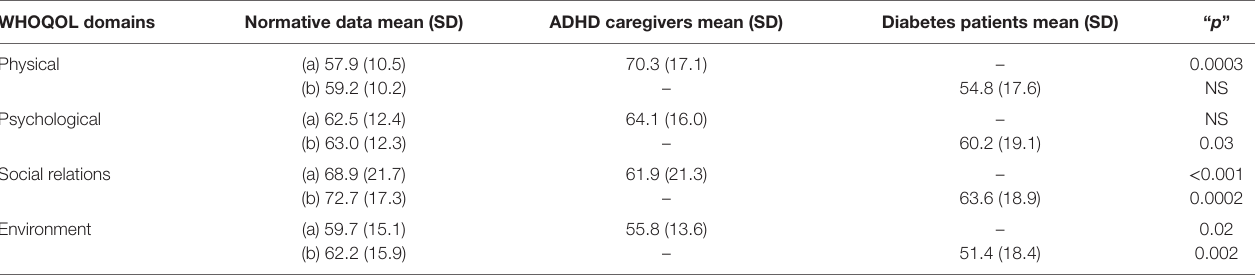
TaBle 2 | comparison of mean WhOQOl-Bref domains between the general population and each of the case groups (aDhD caregivers and diabetes patients). WhOQOl